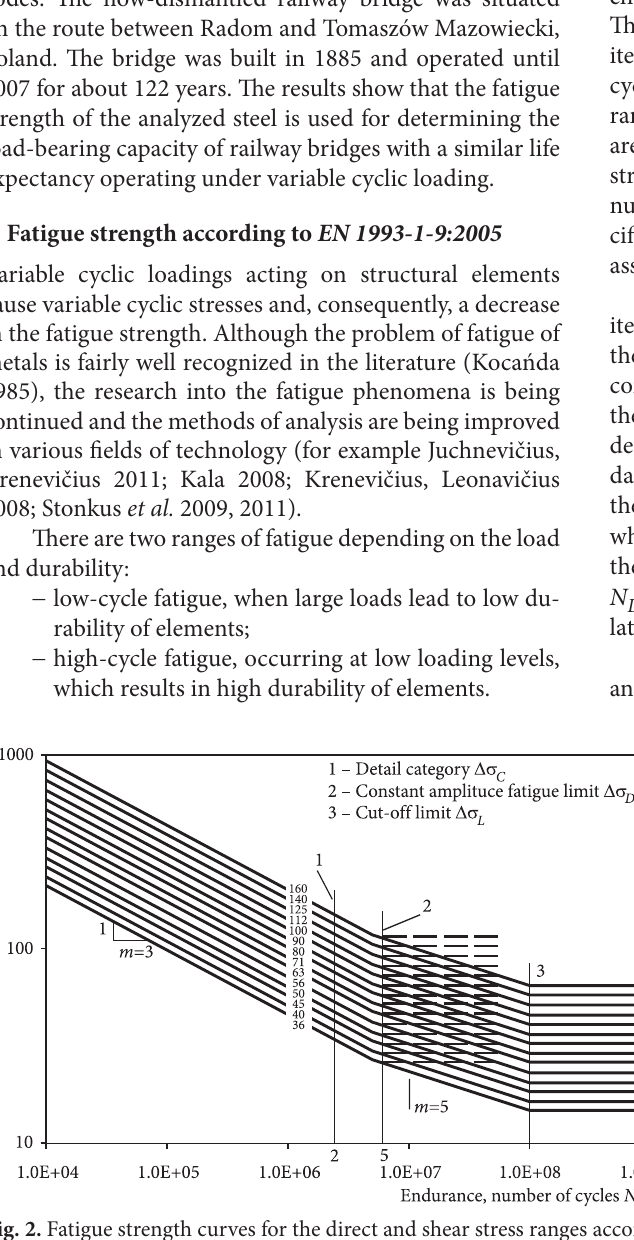
Fig. 2. Fatigue strength curves for the direct and shear stress ranges according to EN